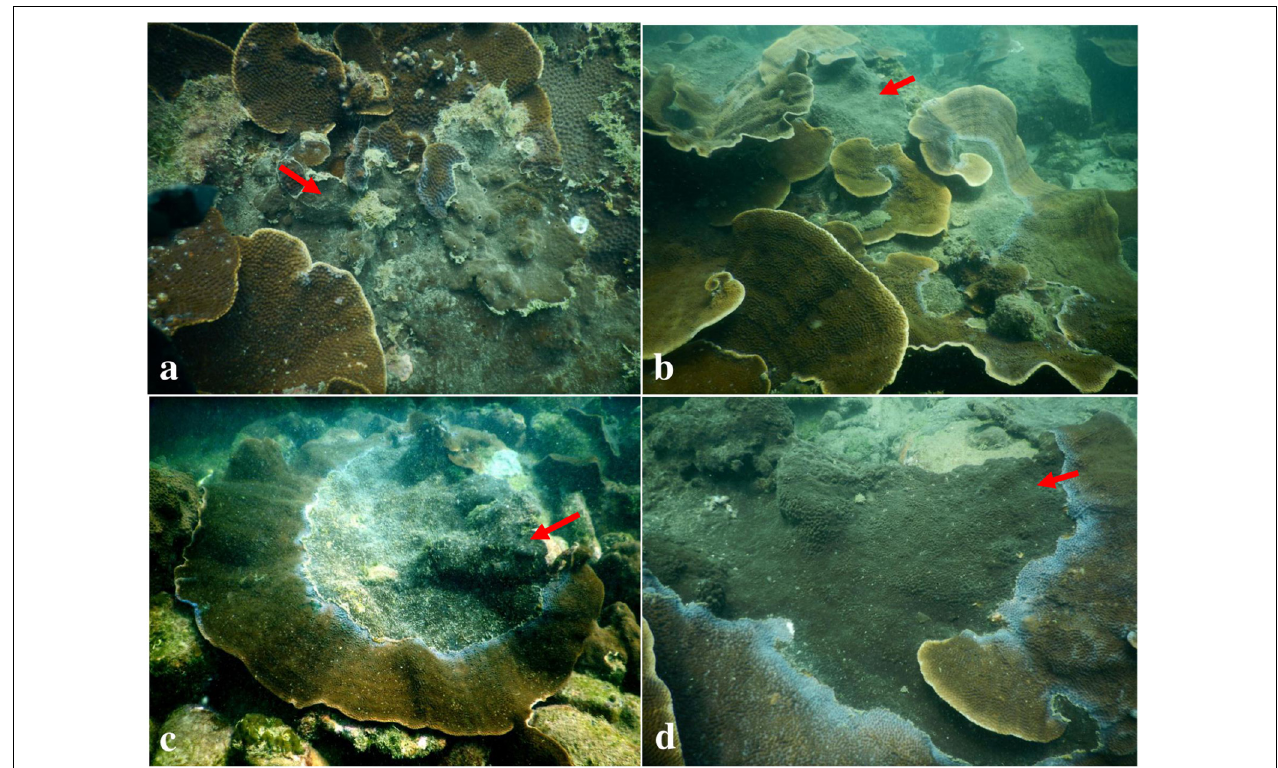
FIGURE 1 | Massive growth forms of Cliona thomasi observed over different live coral colonies of Turbinaria mesenterina (a–d) from the studied site Grande